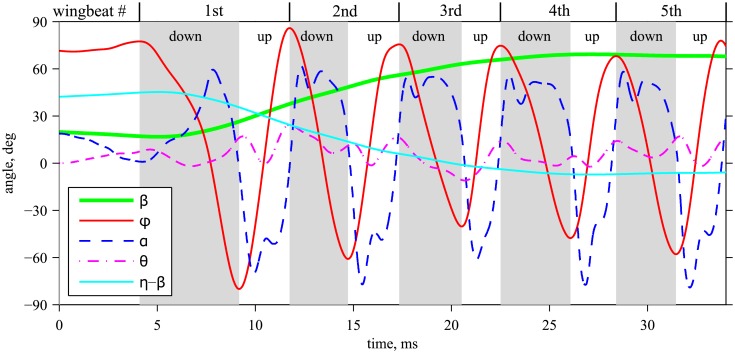
Time evolution of the angular position of the body and of the wings during the voluntary takeoff.Gray shaded regions correspond to downstrokes. η − β is the angle between the horizontal plane and the stroke plane, i.e., the global stroke plane angle [26].